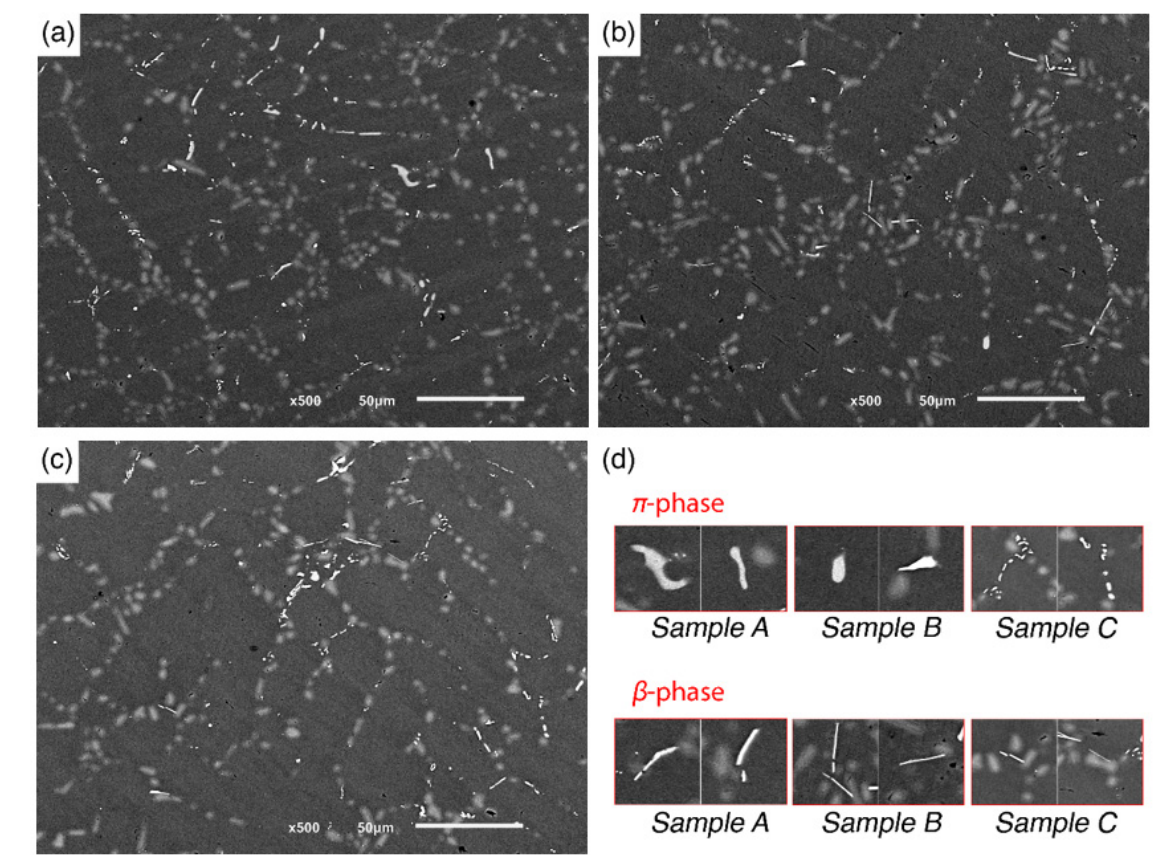
Figure 8. Detailed SEM (BSE mode) micrograph of solution-treated microstructures of ( a ) sample A, ( b ) sample B, ( c ) sample C and ( d ) highlighted intermetallic for each sample.